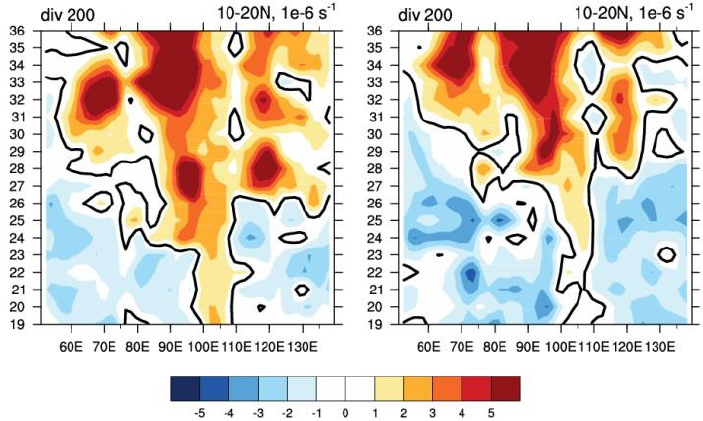
Figure 11. Hovmöller diagram of composite divergence at 200 hPa (shading; 10 −6 s −1 ) along 10°–20° N from Pentad 19 to Pentad 36 in the North (left) and South (right) track cases. Thick contour indicates zero.